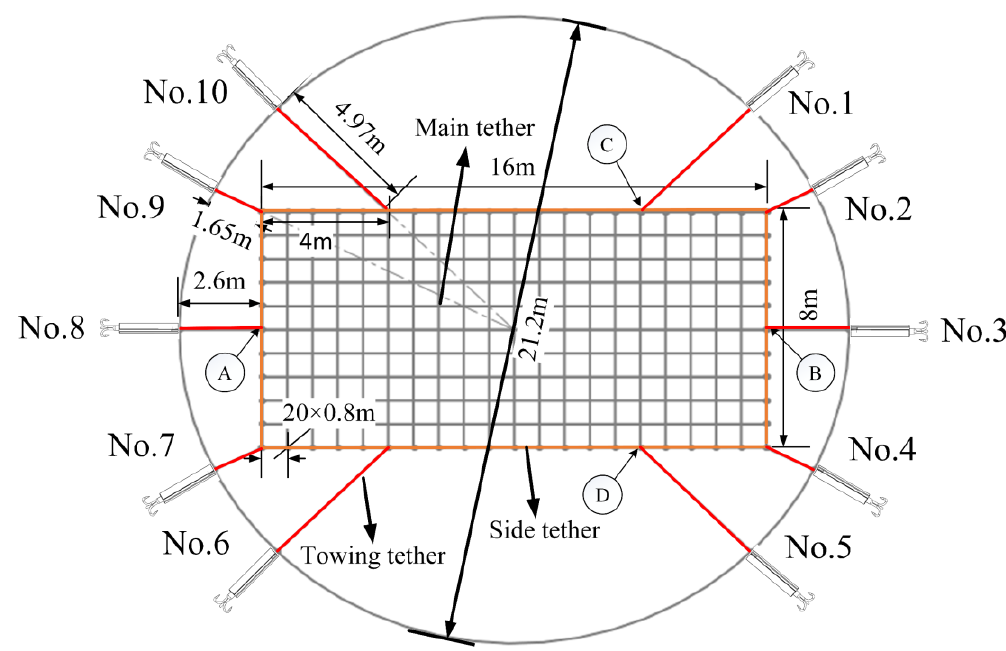
Figure 4. Configuration of rectangular tether-net.